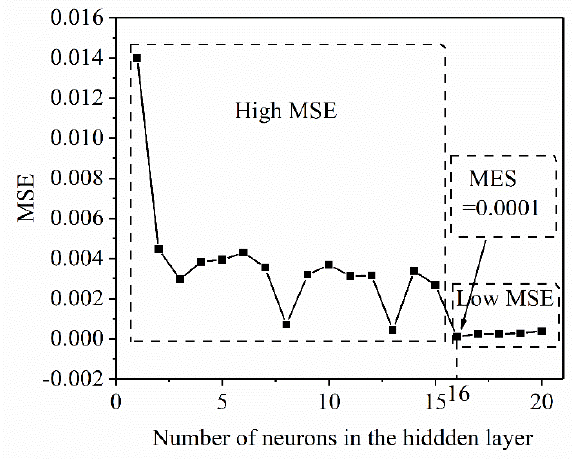
Table 1. Artificial neural network (ANN) training parameters.